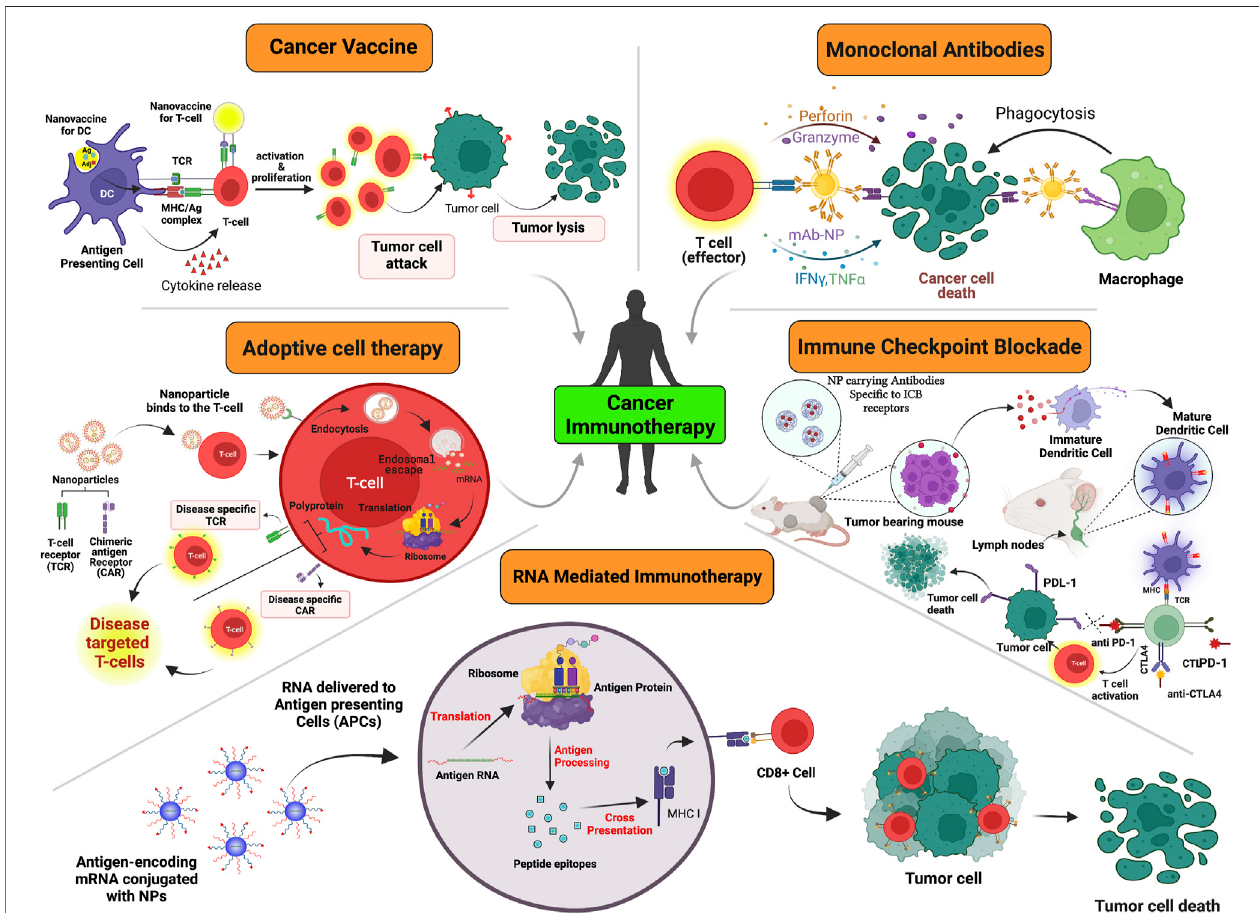
FIGURE 2 | A schematic representation of various modules in which cancer immunotherapy plays a role which includes but is not limited to adoptive cell therapy, monoclonal antibodies, cancer vaccines, ICBs, oncolytic viral therapy and RNA- mediated silencing. Created with Biorender.com.